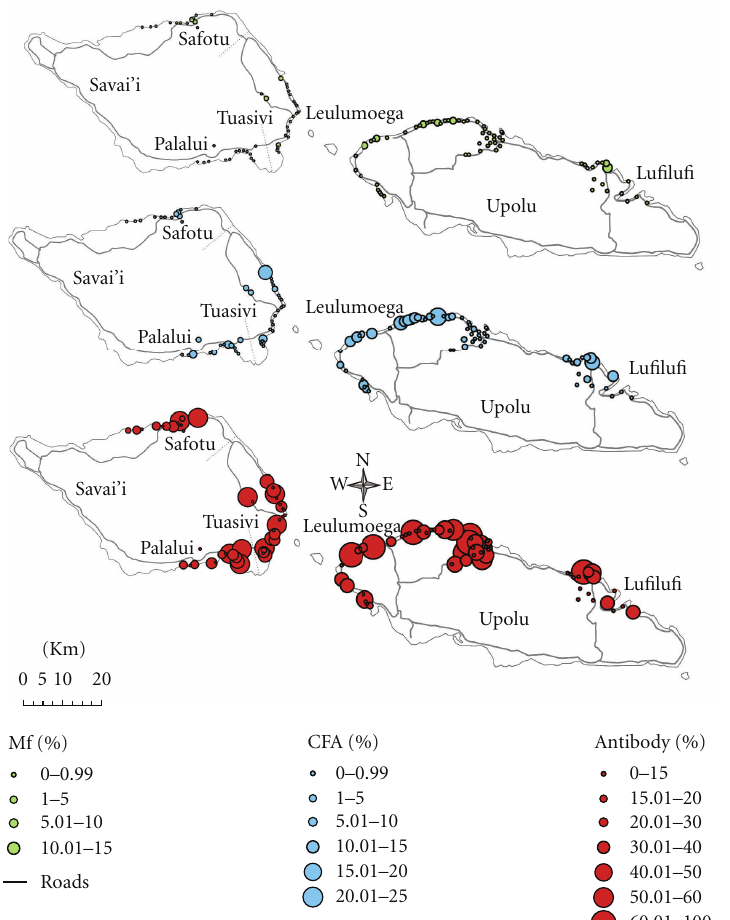
Figure 4: Serological mapping for Mf, CFA, and antibody prevalence across Samoa. Geographical mapping allows quick reference to suspected problem areas or “hot spots” of residual